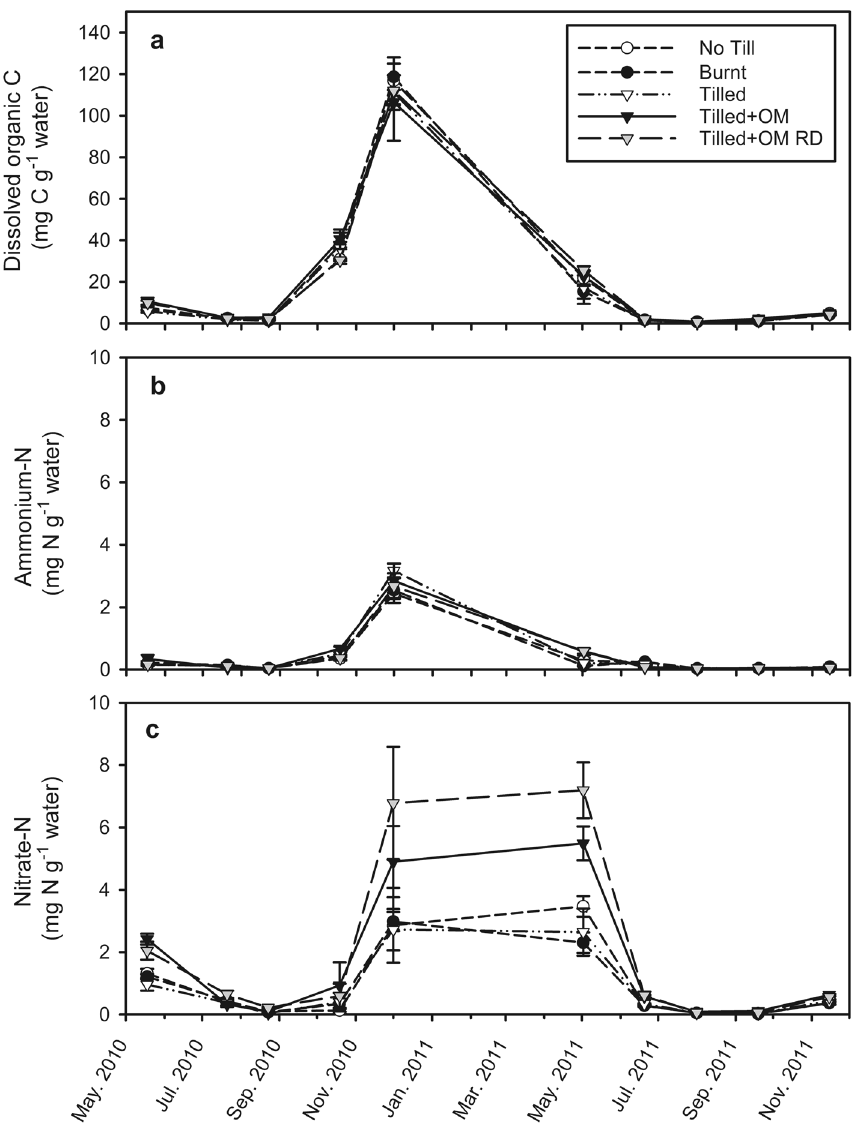
Figure 3. Change in ( a ) dissolved organic carbon; ( b ) ammonium; and ( c ) nitrate in soil (0–10 cm) through time, expressed per gram of soil water. Values are a mean of three field replicates, error bars are ± standard error of the mean. Legend is the same for both panels. Nitrogen fertilizer was applied at seeding (28th May 2010 and 1st June 2011) and at crop emergence (12th July 2010 and 26th July 2011). OM organic matter, RD